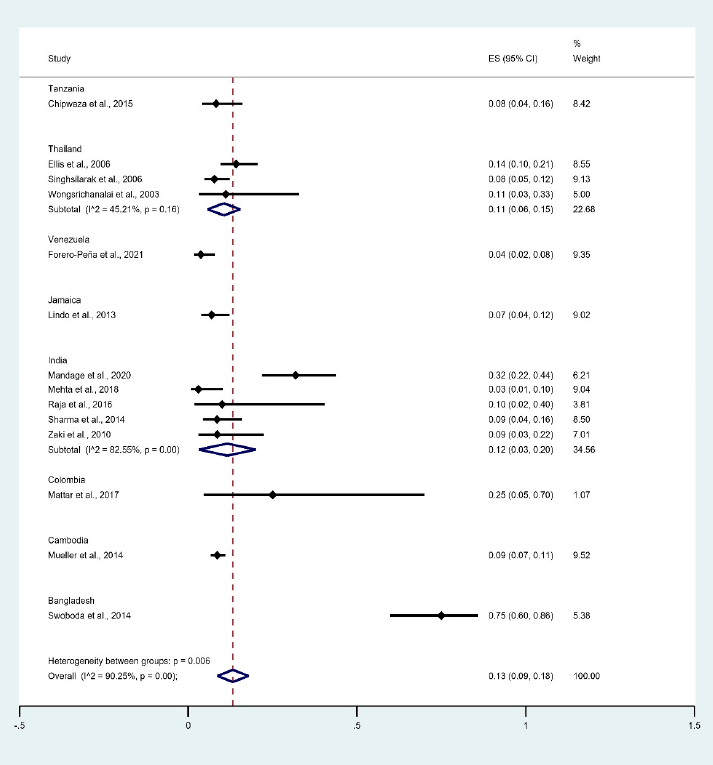
Figure 3. Prevalence of malaria and leptospirosis co-infection among febrile patients by country. % Weighted: the impact proportion of each study to the pooled effect; black dot symbol on black horizontal line: point estimate for each study; black horizontal line: CI, white diamond symbol: pooled prevalence; CI: confidence interval; ES: effect size (prevalence).